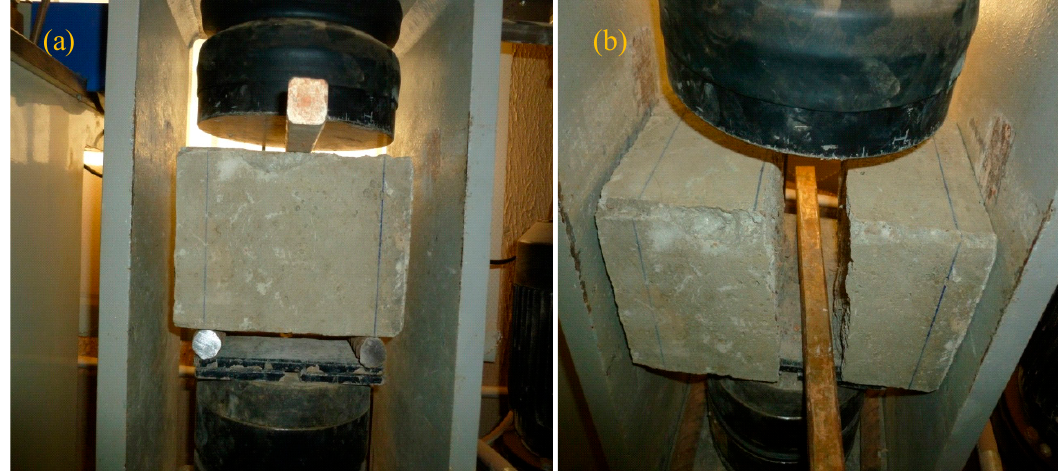
Figure 2. ( a ) Beam testing; ( b ) failure of beam.